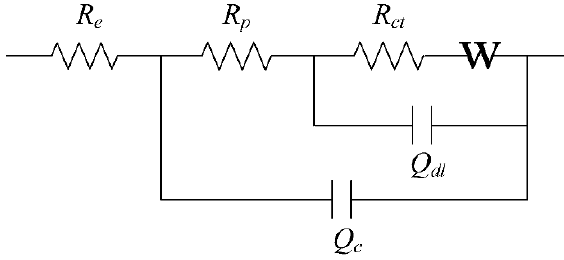
Figure 9. The equivalent circuit used to fit the impedance diagrams in Figure 6.